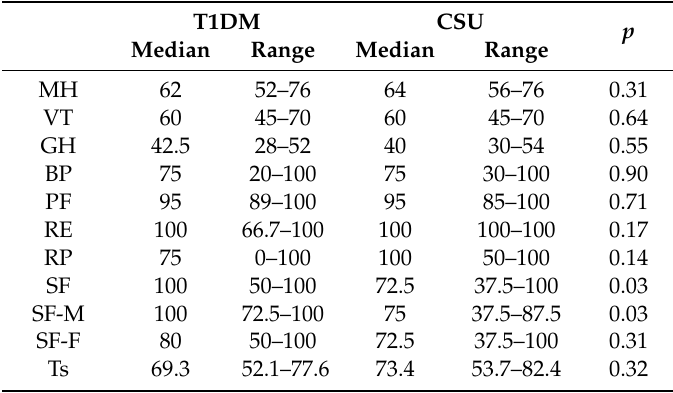
Table 2. Differences in quality of life (QoL) between type 1 diabetes mellitus (T1DM) and chronic spontaneous urticaria (CSU) referring to Short-Form 36 (SF-36) domains: mental health (MH), vitality (VT), general health (GH), bodily pain (BP), physical functioning (PF), role limitations due to emotional problems (RE), role limitations due to physical problems (RP), social functioning (SF), total score (Ts), M—male, F—female.